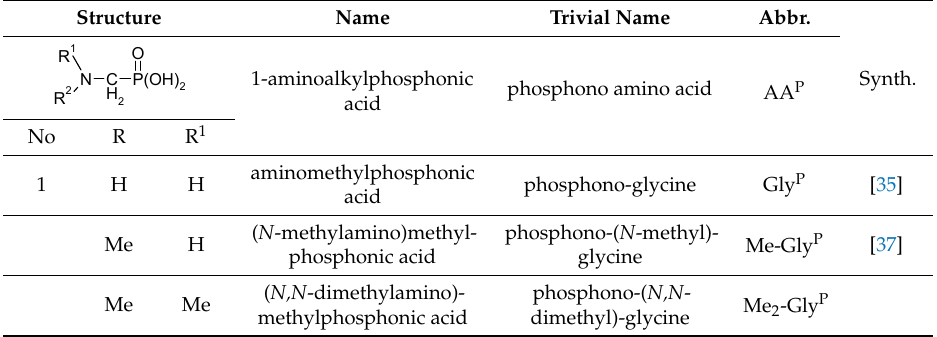
Table 2. Names, abbreviations, and structures of aminophosphonic acids discussed in this work a .